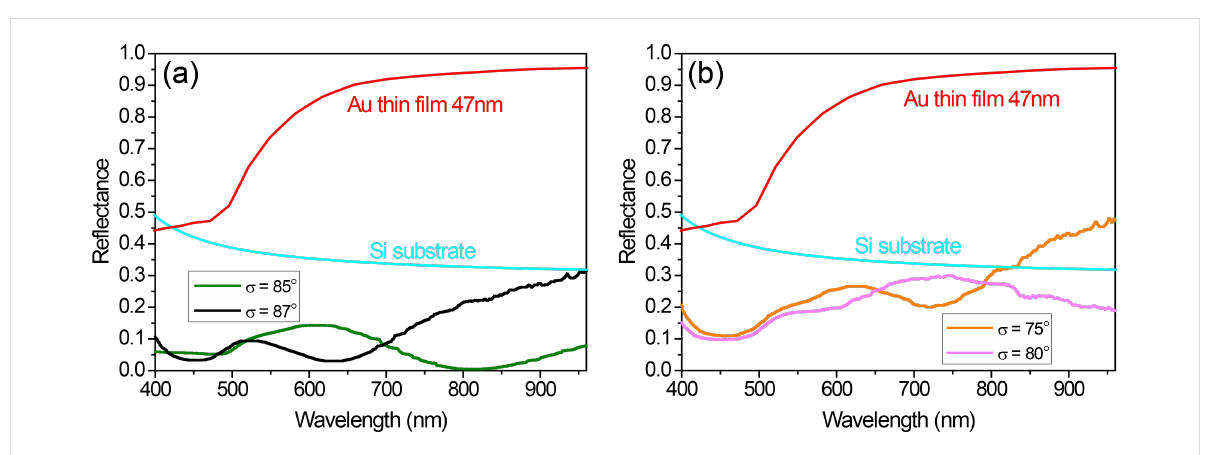
Figure 4: Reflectance spectra of nanostructured Au samples exhibiting black color (a) and golden color (b). For the sake of comparison, the calcu- lated spectra of a bare Si substrate (cyan) and a continuous Au thin film (red) have been also included.